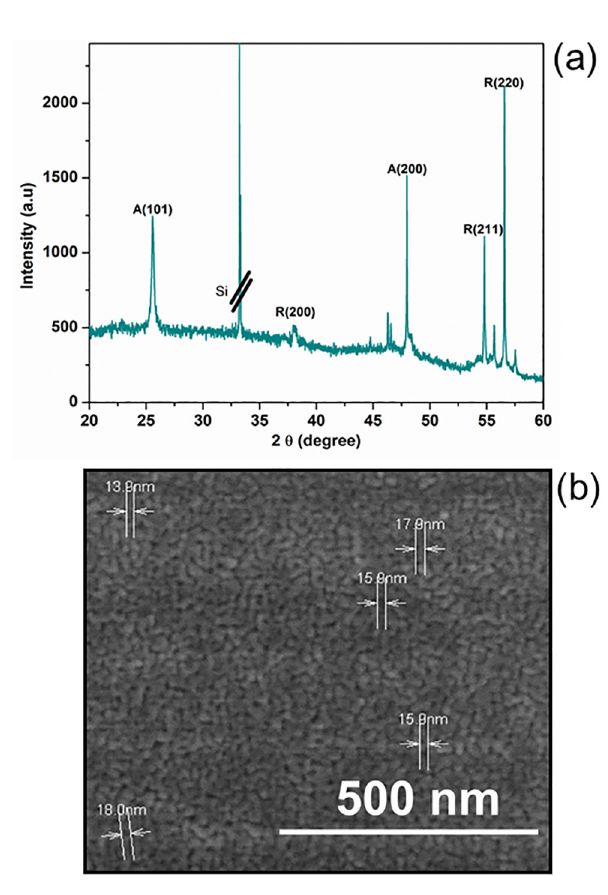
Fig 3. Measurements on sensing surface. (a) XRD spectra of TiO 2 thin film. Annealed TiO 2 thin film was characterized to get highsurface crystallinity. (b) FESEM image of TiO 2 nanoparticles. 100 k magnification was used to scan the TiO 2 structure under ambient